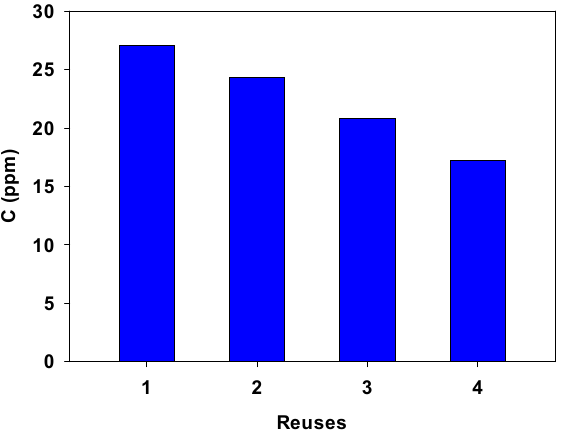
Figure 6. Reuse of HT-DSC for the adsorption of 4-NPhOH. Experimental conditions: 25 mL of adsorbate solution, 100 mg of sorbent, and 22 °C. Where “1” is fresh material.